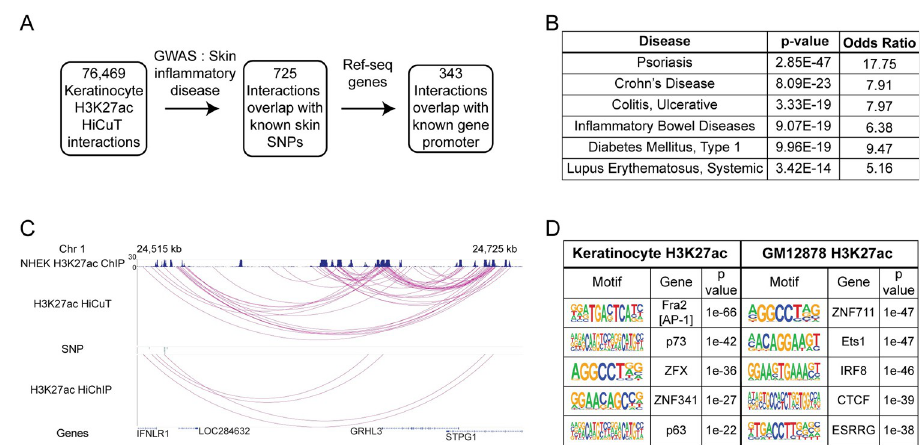
Fig 4. HiCuT identifies long-range promoter-enhancer interactions in primary human keratinocytes. (A) Identifying candidate genes associated with inflammatory skin disease specific single nucleotide polymorphisms (SNPs). (B) Candidate genes analysed by gene ontogeny using EnrichR [19]. (C) WashU epigenome browser view of chromatin interactions in primary human keratinocytes. The H3K27ac ChIP tracks from are from ENCODE NHEK cells (GSM733674) followed by chromatin interactions identified by HiCuT or HiChIP [15,17]. Chr, Chromosome. (D) Top transcription factor binding motifs identified by Homer in of H3K27ac HiCuT anchor regions from primary keratinocytes and GM12878 cells